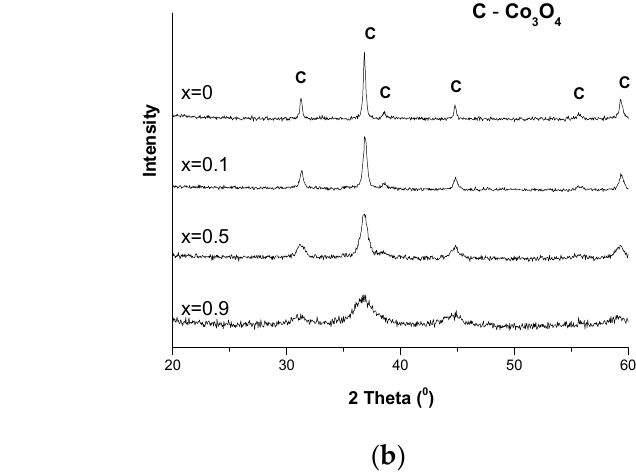
Table 1. Physicochemical characteristics of the Cs/Me x Co 3 − x O 4 (Me: Ni or Mg, x = 0–0.9) samples and the half-transformation temperature (T 50